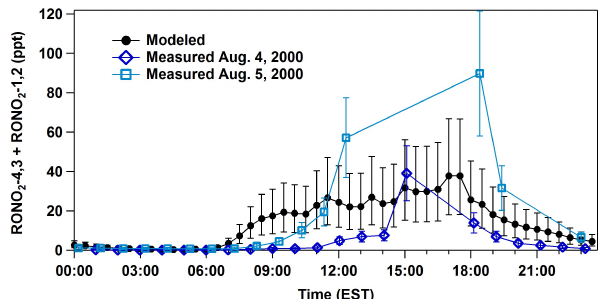
Fig. 8. Comparison of the sum of the concentrations of the two most abundant modeled ( ∼ 12m above forest canopy) isoprene nitrate isomers (RONO 2 -4,3 and RONO 2 -1,2) with the two most abundant isoprene nitrate isomers measured ( ∼ 10m above the forest canopy) at UMBS (Ford, 2001; Giacopelli et al., 2005). Error bars for mod- eled concentrations represent sensitivity to the range of isoprene emission